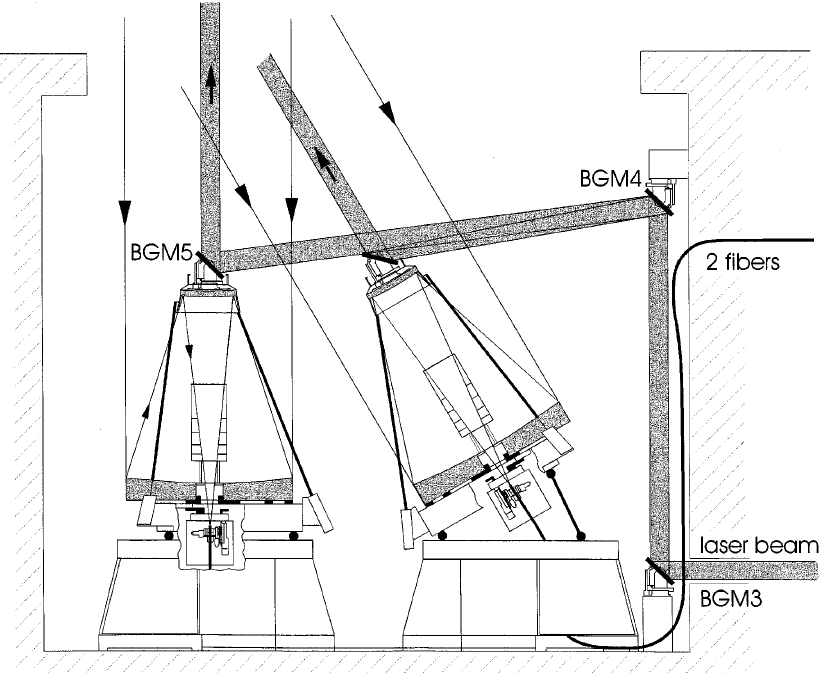
Fig. 3. Laser beam guidance and telescope schematic: The laser beams enter the tele- scope hall horizontally with a diameter of 20 cm about 1.5 m above the floor. The mirrors BGMs 3 deflect them upward until they hit BGMs 4 well above the telescope structure. The beams are guided slightly downward to the tops of the secondary mirror assemblies, where BGMs 5 align the laser beams with the telescope LOSs. Thus, the laser beams are emitted into the atmo- sphere coaxially with the LOSs of the telescopes. Once aligned, the BGM 5 is controlled by a servo loop which is driven by a CCD-camera near the